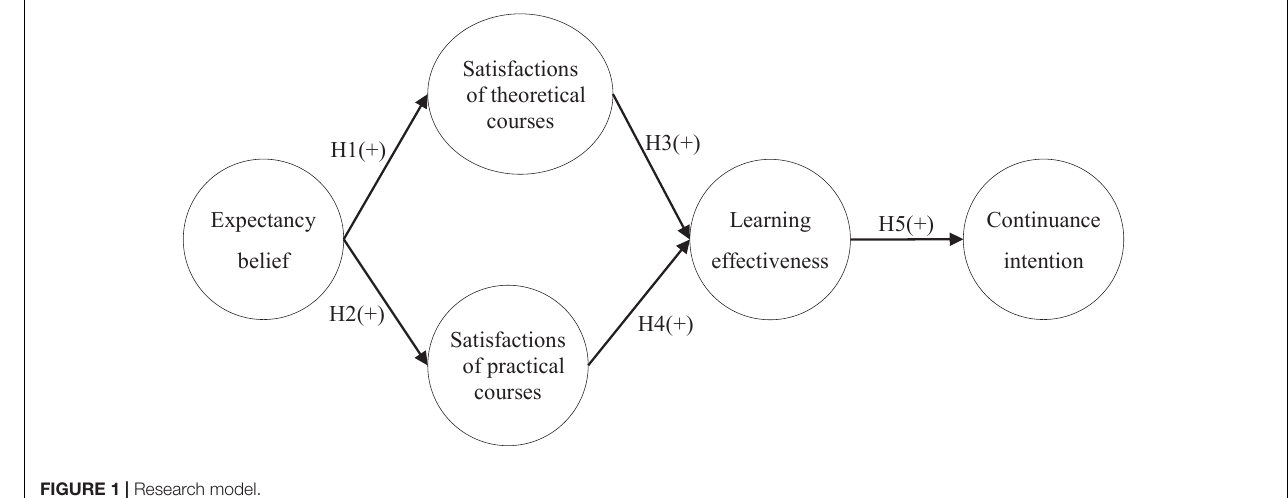
FIGURE 1 | Research